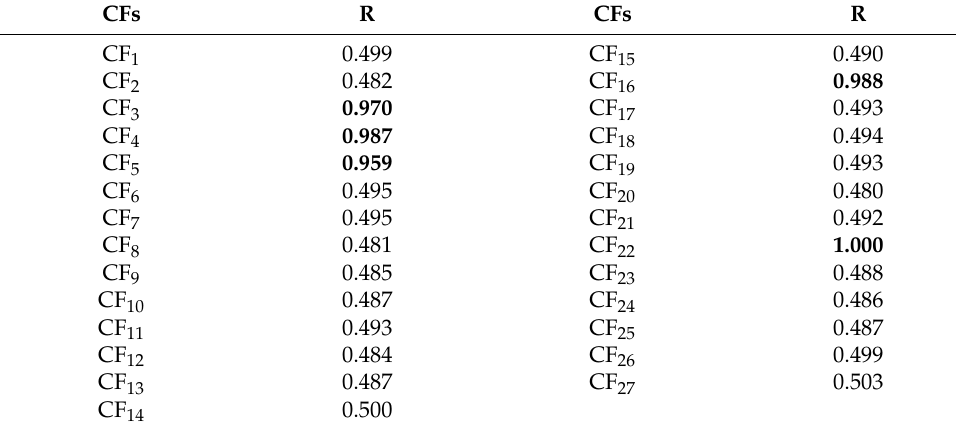
Table 13. Values of R for CFs.